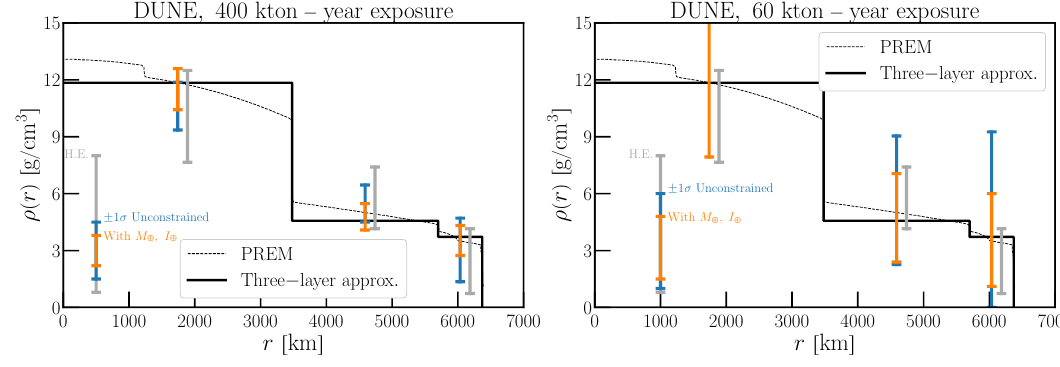
Figure 19 . DUNE’s sensitivity to the Earth matter profile as a function of the radius for the constrained analysis (orange data points), accounting for Earth’s total mass and moment of inertia measurements, as well as the unconstrained analysis (blue data points). For comparison, the gray data points indicate the constraints on the densities when the mass and moment of inertia of the Earth are known and the hydrostatic equilibrium condition is imposed. The solid black line corresponds to our 3-layer Earth model, while the PREM profile is shown for reference as a dashed line. The left panel corresponds to 400 kton-year exposure, while the right panel corresponds to 60 kton-year exposure. Note that the unconstrained analysis with lower exposure does not lead to meaningful determinations of the core and upper mantle densities, and thus we do not display the corresponding blue data points in the right